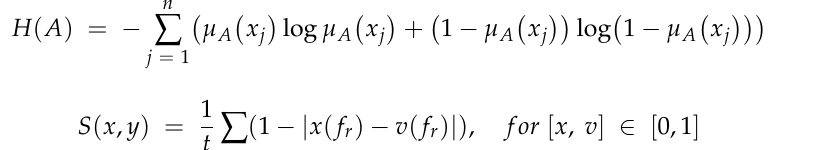
Figure 5. Feature plot for Parseval energy, skewness, kurtosis, Shannon entropy, and AR-coeffi- cients.